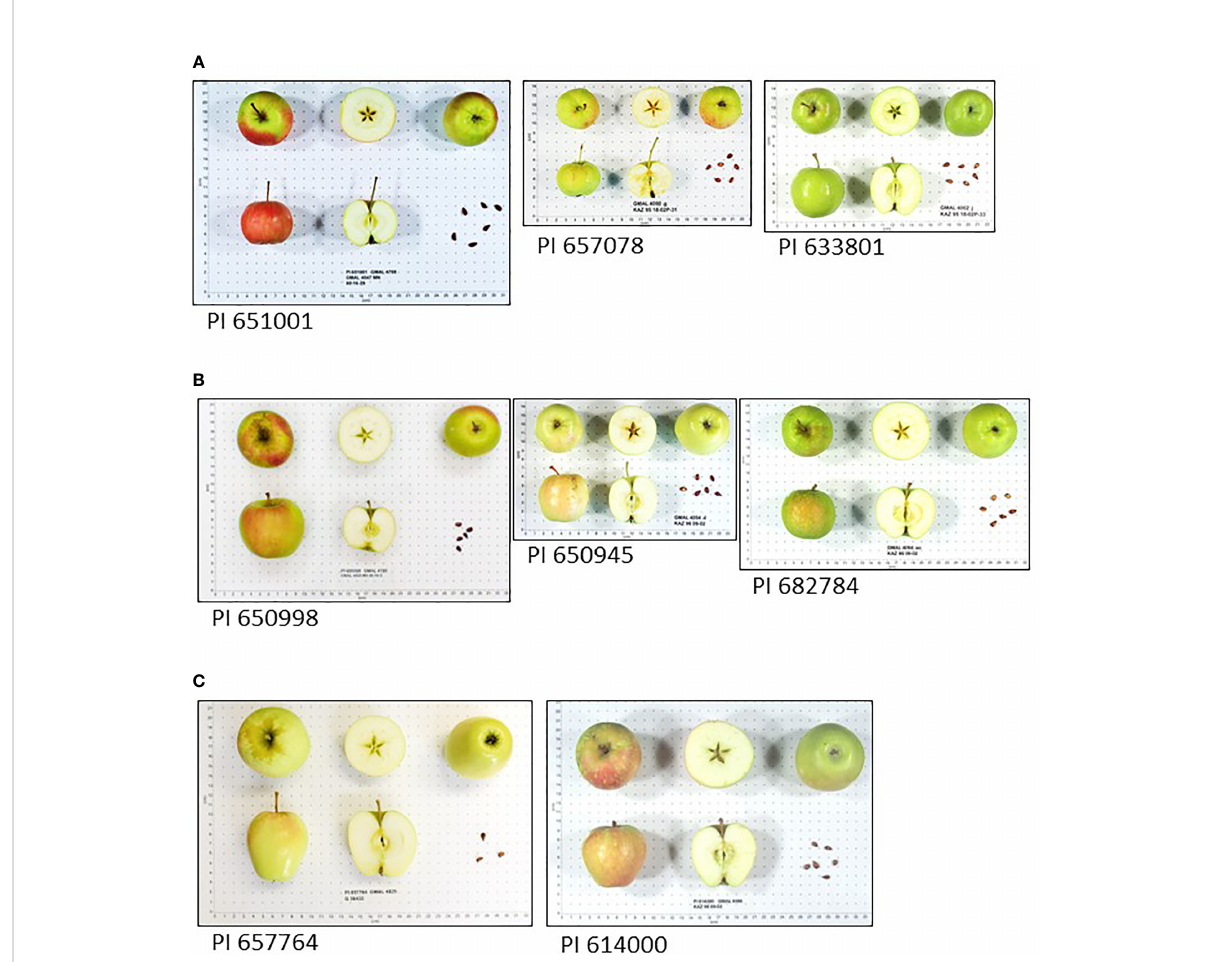
FIGURE 4 Malus fruit images from the USDA-NPGS apple collection (A) Three accessions collected in Kazakhstan determined to be pure M. sieversii ; (B) Three accessions collected in Kazakhstan determined to be M. sieversii-M. domestica hybrids with ‘ Rosmarina Bianca ’ as a parent; (C)